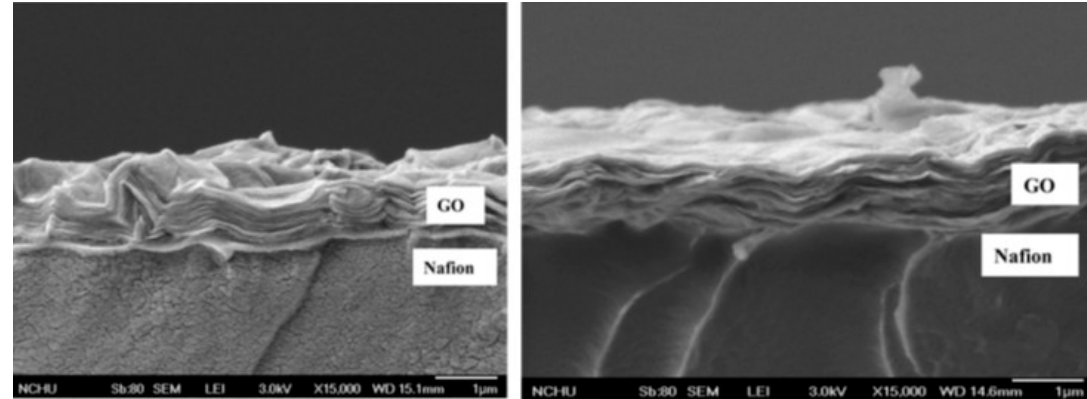
Figure 11. SEM images of the GO-laminated Nafion ® membrane at different magnitudes. Reproduced from [72], with permission from Elsevier, 2013.